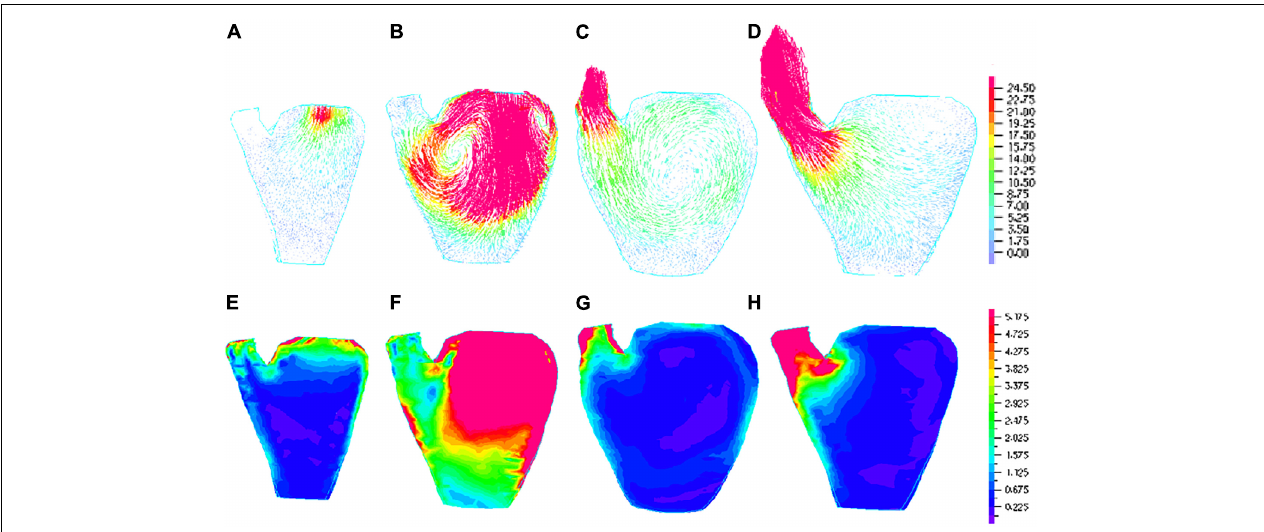
FIGURE 5 | Flow velocity and flow shear stress (FSS) plots of right ventricular outflow tract (RVOT) pacemaker model. (A) Velocity vector plot at begin-filling, t = 1.28s, maximum velocity = 29.08cm/s, mitral valve opens, filling begins, aortic valve is closed; (B) . Velocity vector plot at the peak of filling, t = 1.56s, maximum velocity = 329.9cm/s, mitral valve is open, aortic valve is closed; (C) . Velocity vector plot at begin-ejection, t = 1.78s, aortic valve opens, ejection begins, mitral is closed, maximum velocity = 70.96cm/s; (D) . Velocity vector plot at t = 2.06s, maximum velocity = 164.9 cm/s, aortic valve is open, mitral valve is closed; (E) . FSS band plot at begin-filling, t = 1.28s, maximum = 10.87 dyn/cm 2 ; (F) . FSS band plot at the peak of filling, t = 1.56s, maximum = 192.9dyn/cm 2 ; (G) . FSS band plot at begin-ejection, t = 1.78s, maximum = 51.24dyn/cm 2 ; (H) . FSS band plot at peak of ejection, t = 2.06s, maximum = 106.8dyn/cm 2 .